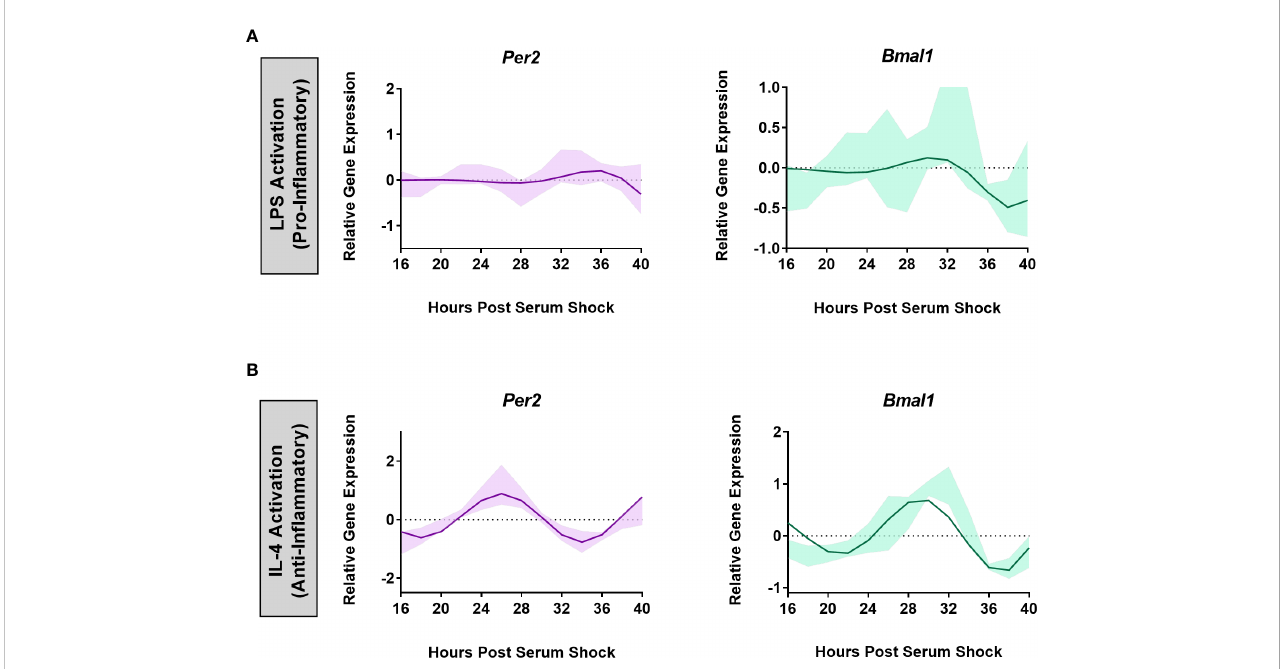
FIGURE 2 BV2 circadian clock oscillations are affected by the cell ’ s in fl ammatory status. ECHO fi tted plots for mRNA expression of clock genes Per2 and Bmal1 in BV2 microglia (n = 3) under (A) LPS (1 µg/mL) (pro-in fl ammatory) and (B) IL-4 (20 ng/mL) (anti-in fl ammatory) activation. Data represented as fold change in expression using Hprt1 as a reference gene and HSP0 as a reference sample for the DD Ct method of data analysis. Bold line represent model fi t with shaded region representing the standard deviation of model at each time point. All plots had p<0.05 for ECHO signi fi cance fi